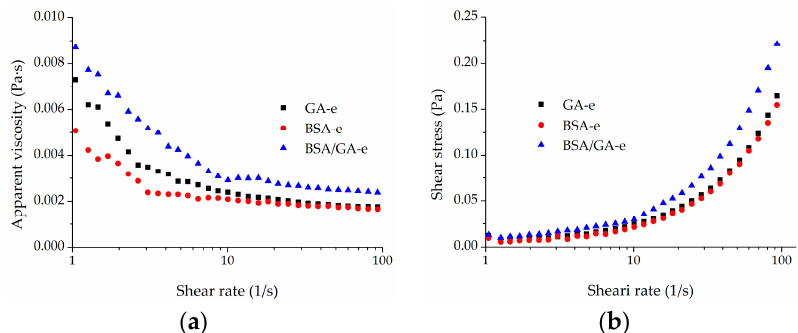
Figure 1. The variation of apparent viscosity ( a ) and shear stress ( b ) with the shear rate of the three emulsions studied. Table 2. The rheological parameters from the Herschel–Bulkley model of the three emulsions studied.